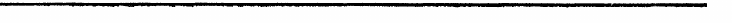
Fig. 8. Cryphocricos hungerfordi; detail of one leaf-like seta on fifth ventral abdominal paratergite. Note longitudinal ridges and tapering tip, which points posterolaterally (lower left). Surrounding setae were rubbed off, revealing tips of underlying plastral hairs and apparently socketed base o.f seta. Scale line--2 #m. Fig. 9. C. barozzii; sense organ on third ventral abdominal paratergite Sense organ is composed of elongated leaf-like setae. Tips of shorter leaf-like setae, covering rest of paratergite, are visible at bottom and upper left of figure. Right lateral, bottom posterior. Scale line 30 #m. F’ig. 10. C. barozzii; detail of Fig. 9, showing longitudinal ridges o.n elongated leaf-like setae. Scale line- 2